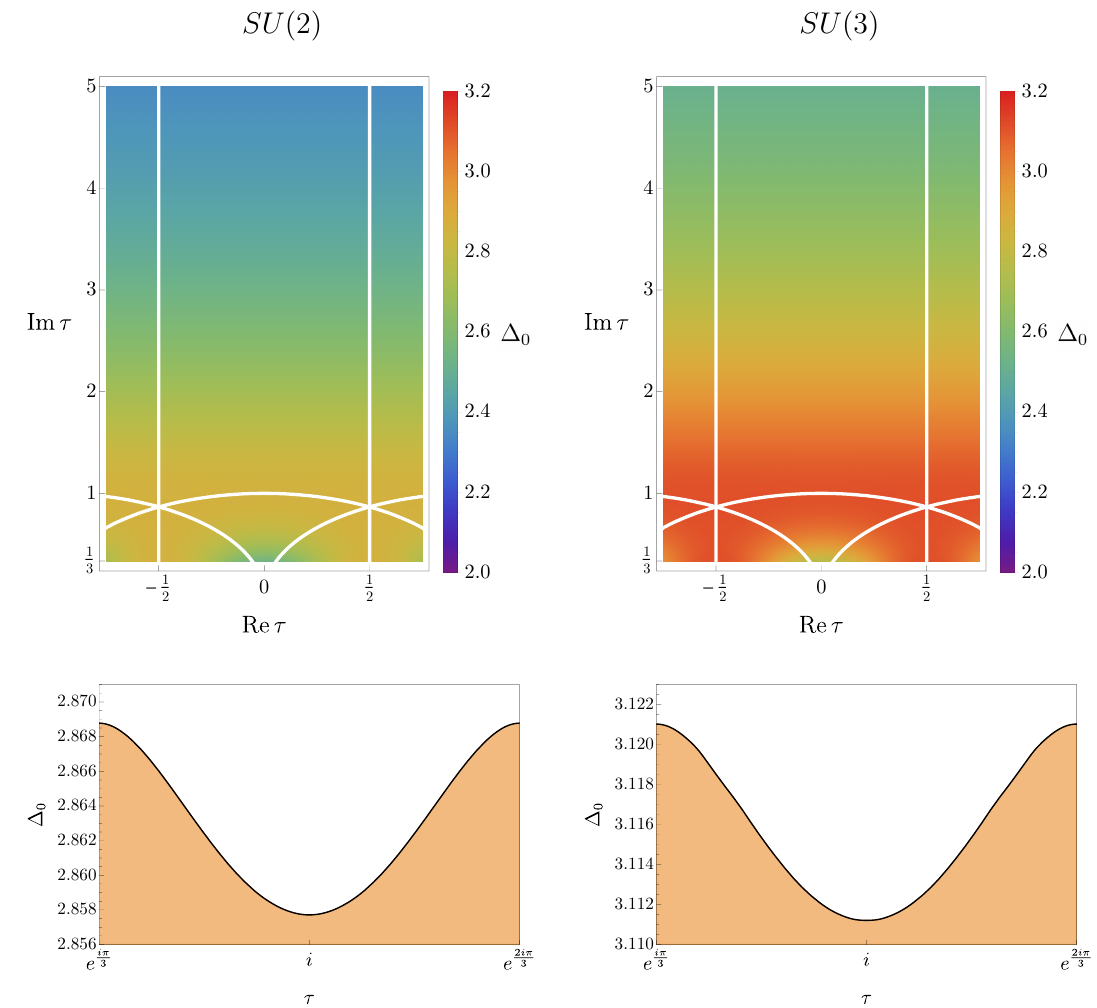
Figure 8 . Upper bounds on the scaling dimension of the lowest scalar as a function of complex coupling τ ( above ) and on the bottom boundary of the fundamental domain ( below ), obtained with bootstrap resolution Λ = 39 . The dependence of the bounds on θ is weak within the fundamental domain, varying by less than 1% between θ = 0 and θ = π . Note that, like the localization inputs, the slope of these upper bounds go to zero at the Z 2 self-dual point τ = i and the Z 3 self-dual point τ = e πi/ 3